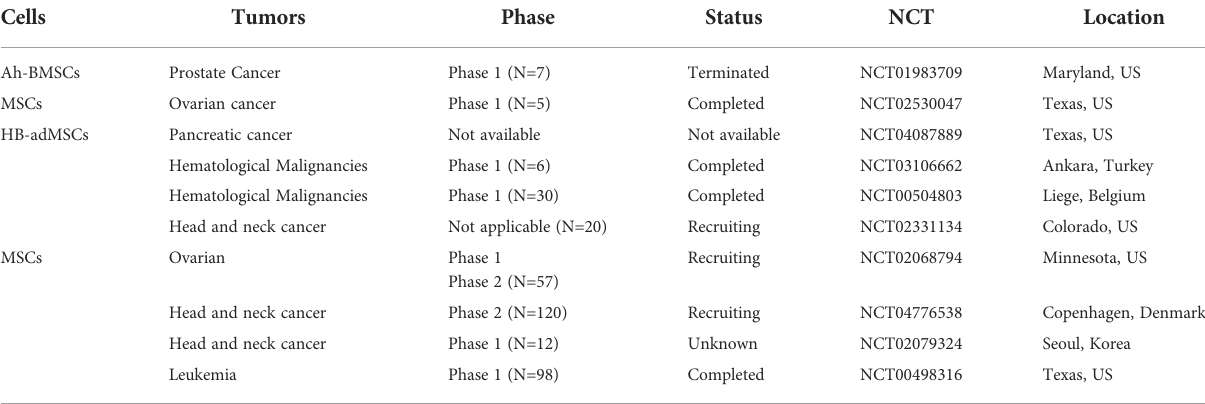
TABLE 4 Anti-cancer MSCs in registered clinical trials (Clinicaltrials. gov, National Institutes of Health) as of August 2021.